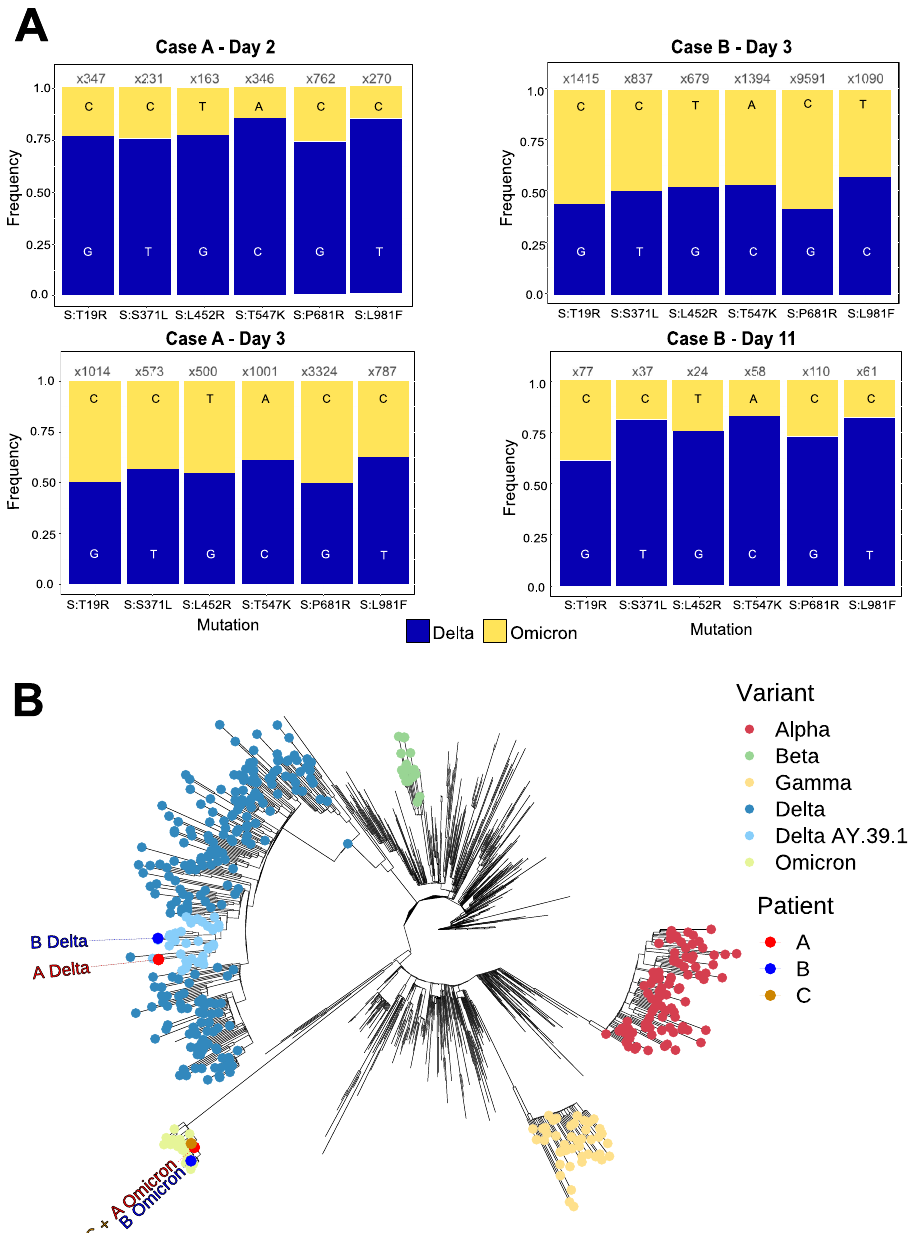
Fig. 3 Population and phylogenetic analysis of two cases of SARS-CoV-2 co-infection with Delta and Omicron VOCs. A Population analysis of key lineage-de fi ning mutations in the SARS-CoV-2 spike gene for each specimen. Nucleotide frequency and relative coverage of genomic regions speci fi c for either Omicron or Delta. The X -axis represents genomic positions and Y -axis indicates their relative frequencies derived from RVOP data. B Unrooted maximum likelihood phylogeny representing the sequences obtained from Cases A, B and C in the context of global diversity of SARS-CoV-2. Genomes generated as part of this study are labelled individually. The predominant Delta lineage in Australia, AY.39.1, is highlighted. The Delta strains from cases A and B are from separate clades of AY.39.1 circulating in Australia, whereas the two Omicron strains are both in the same sub-lineage of Omicron (BA.1) which dominated in Australia in December 2021 – January 2022. Note that the Omicron samples from patients A and C are identical and hence overlap. Branch lengths are scaled according to the number of nucleotide substitutions per Bioinformatic analysis of Illumina data . Raw sequence data fi les were processed sequences was conducted using iVar 21 , with soft clipping over primer regions using an in-house quality control procedure prior to further analysis (Fig. 1) as (version 1.2.1, min. read depth >10x, quality >20, min frequency threshold of 0.1). described previously 11,12 . De-multiplexed reads were quality trimmed using Single nucleotide polymorphisms (SNP) were de fi ned based on an alternative frequency >0.75 whereas minority allele frequency variants (MFV) were de fi ned by Trimmomatic v0.36 (sliding window of 4, minimum read quality score of 20, an alternative frequency between 0.1 and 0.75. Variants falling in the 5 ’ and 3 ’ UTR leading/trailing quality of 5 and minimum length of 36 after trimming) 19 . Brie fl y, regions were excluded. Polymorphic sites that have previously been highlighted as reads were mapped to the reference SARS-CoV-2 genome (NCBI GenBank problematic were monitored 22 . To ensure the accuracy of variant calls only gen- accession MN908947.3) using Burrows-Wheeler Aligner-mem version 0.7.17 20 , with unmapped reads discarded. Average genome coverage was estimated by omes with >90% genome coverage and a mean depth of >100x were included. The determining the number of missing bases (Ns) in each sequenced genome. For MFV calls were excluded in the base pair either side of the 5 ’ or 3 ’ -end of indels due amplicon generated reads variant calling and the generation of consensus to potential mis-mapping. SARS-CoV-2 lineages were inferred using Phylogenetic